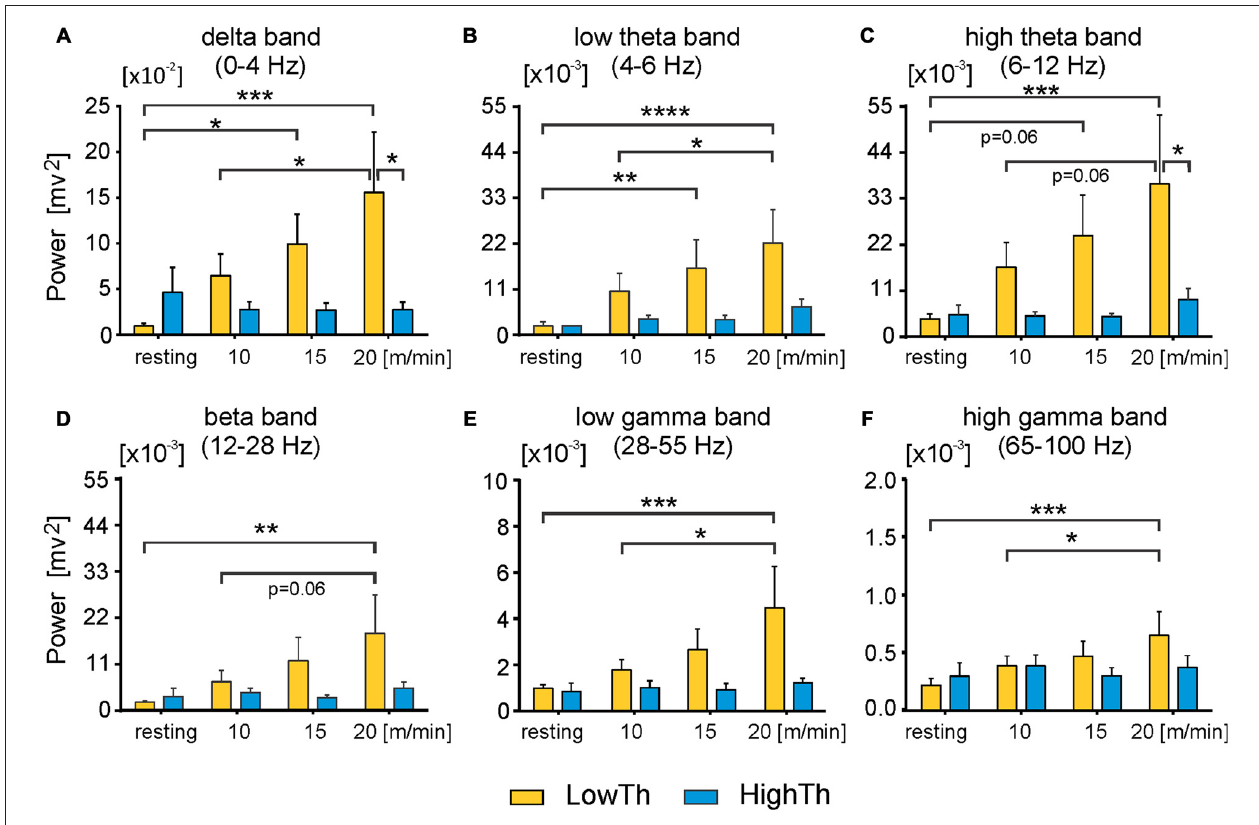
FIGURE 6 | Power of all analyzed frequency bands in LFPs significantly increases in low threshold MLR sites but not high threshold sites as locomotor speed increases. Power of delta (A) low and high theta band ( B,C respectively) and beta band (D) significantly increases in LowTh sites, but not HighTh sites as voluntary locomotor speed increases. (E,F) Power of low and high gamma band in LowTh sites also shows significant increases as locomotor speed increases. Note, difference in scaling between individual plots for power of different bands. Power of any band is the integral of the power in the specific frequency ranges: delta: 0–4 Hz; theta low: 4–6 Hz; theta high: 6–12 Hz; beta: 12–28 Hz; gamma low: 28–55 Hz; gamma high: 65–100 Hz ( n = 8 LowTh; n = 7 HighTh). ∗ P < 0.05, ∗∗ P < 0.01, ∗∗∗ P < 0.001, ∗∗∗∗ P <